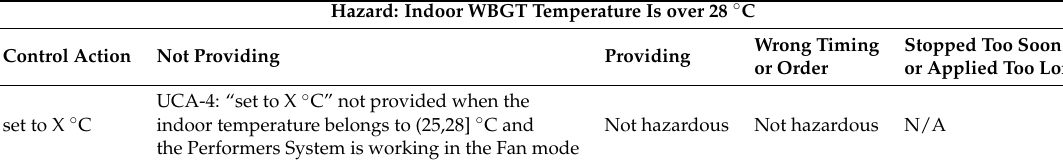
Table 6. UCAs for the control action “set to X ◦